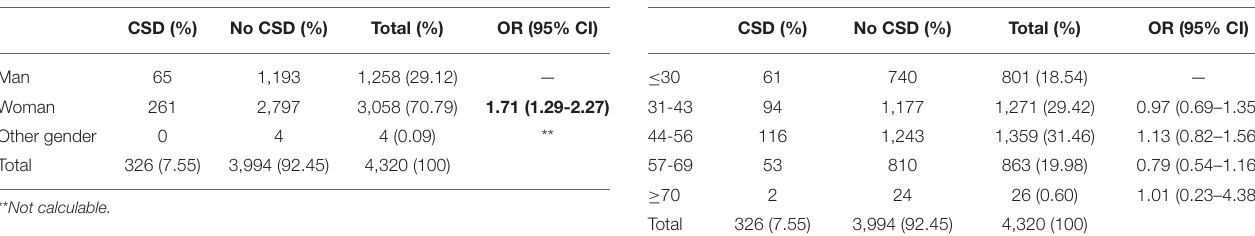
TABLE 2 | Characteristics of the respondents: CSD stratified by gender. TABLE 3 | Characteristics of the respondents: CSD stratified by